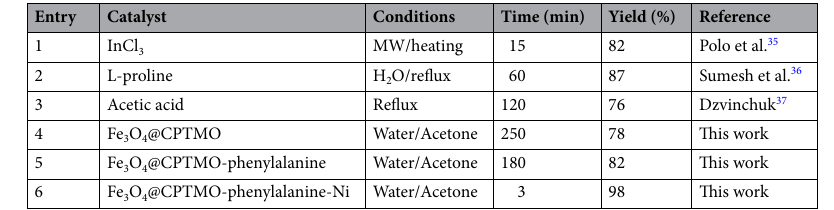
Table 4. Comparison of the effect of various catalysts’ efficiency in the formation of compound 4b